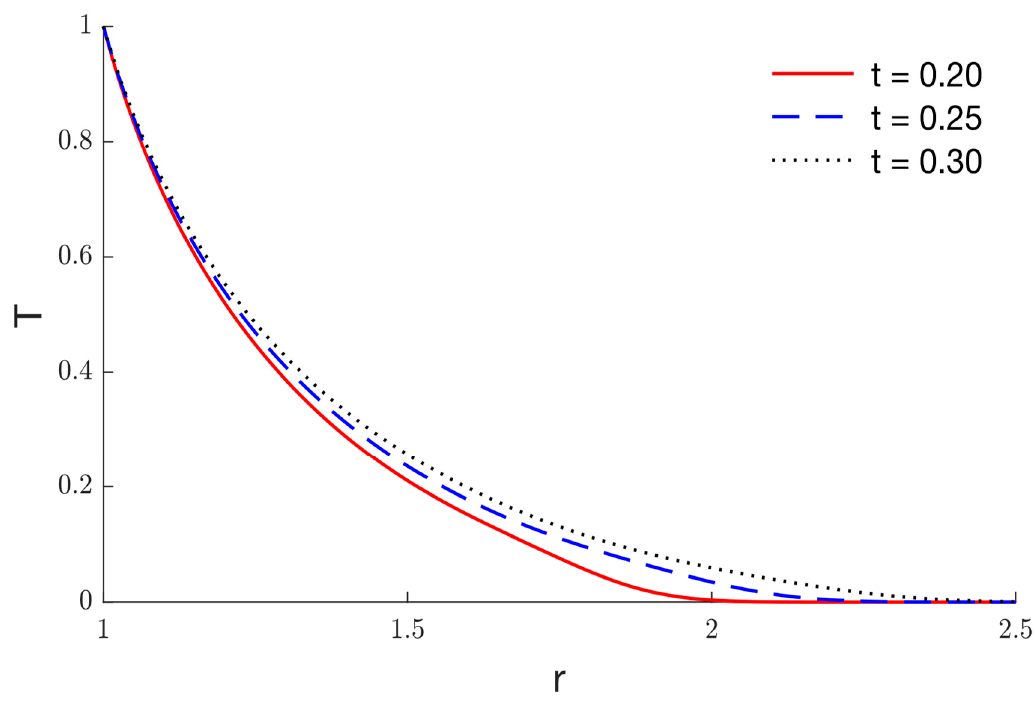
Figure 10. The temperature variation 𝑇 for different values of time.